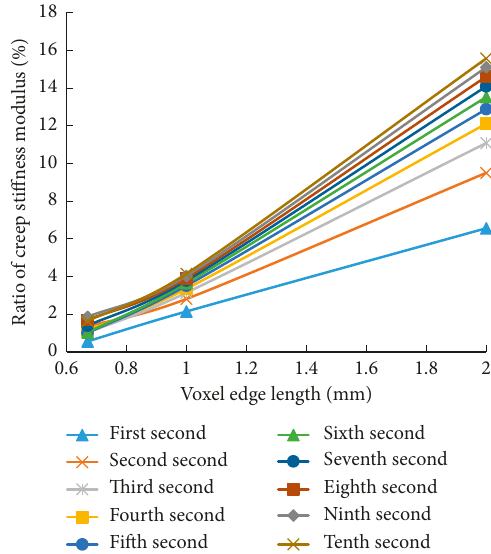
Figure 10: Relationship between ratio of creep stiffness modulus and voxel edge length.